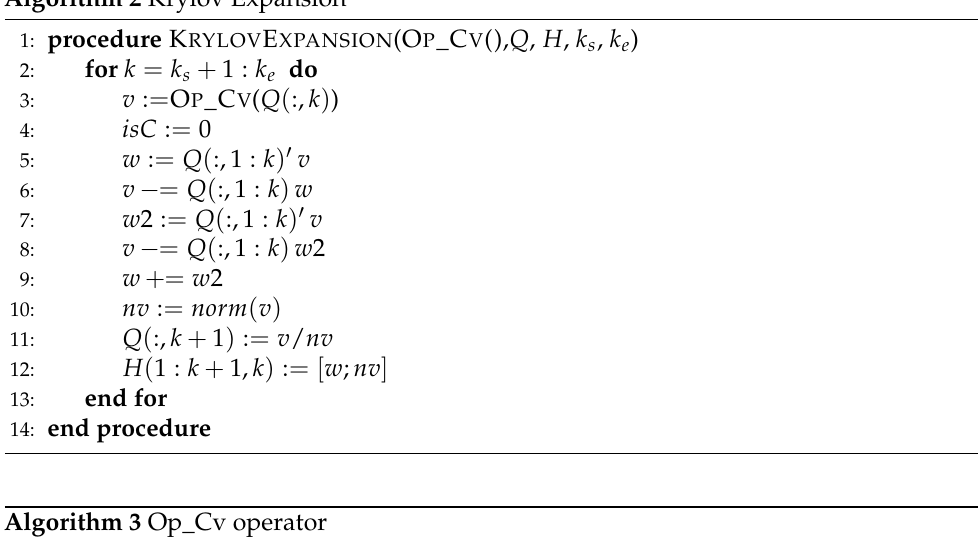
Algorithm 2 Krylov Expansion